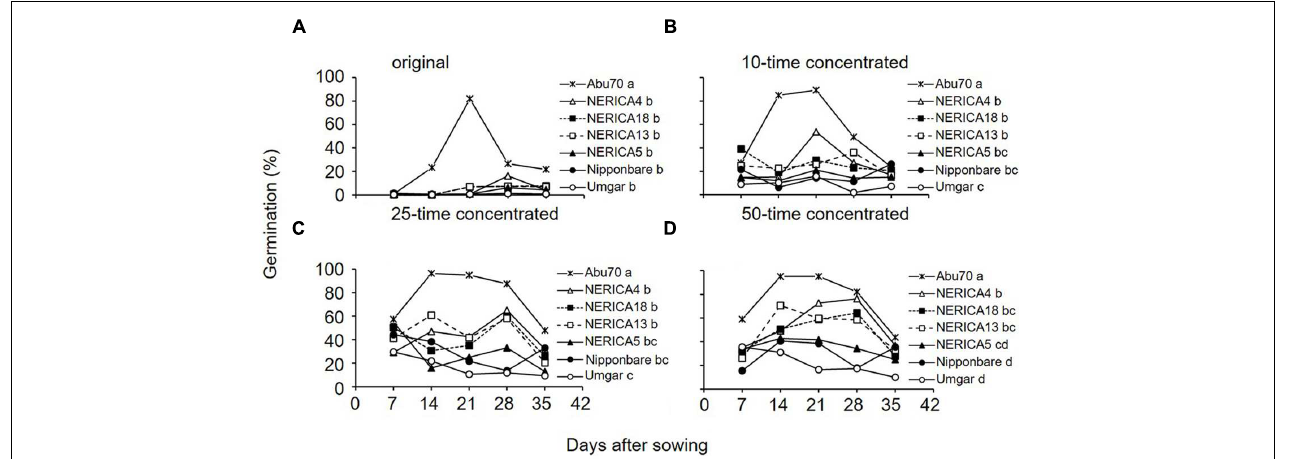
FIGURE 8 | Germination inducing activity of root exudates from Umgar, NERICA5, NERICA13, Nipponbare, NERICA4, and NERICA18 grown in a growth chamber. Original (A) , 10-time concetrated (B) , 25-time concentrated (C) and 50-time concetrated (D) root exudates were used in the germintion test. The percentage values were arcsine transformed, compared by multiple mean-separation tests among rice and sorghum varieties and back-transformed. Different letters next to variety name indicate significant difference ( p < 0.05) by Tukey’s HSD test pooled across sampling date.